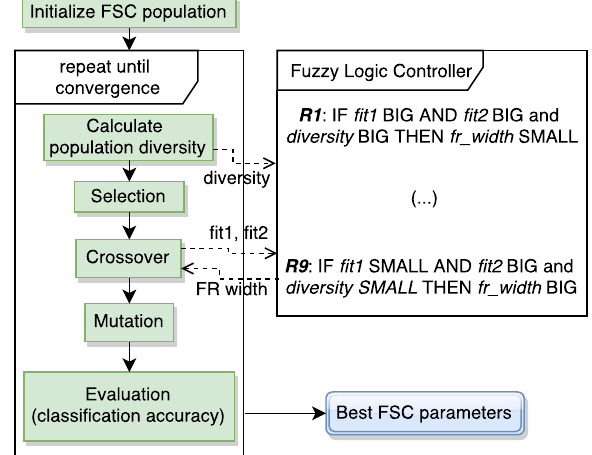
Figure 7: Overview of GA for finding best FSC parameters. FLC adapts the FR width for crossover using 9 fuzzy rules based on the population diversity and the parents’ fitness (fit1,